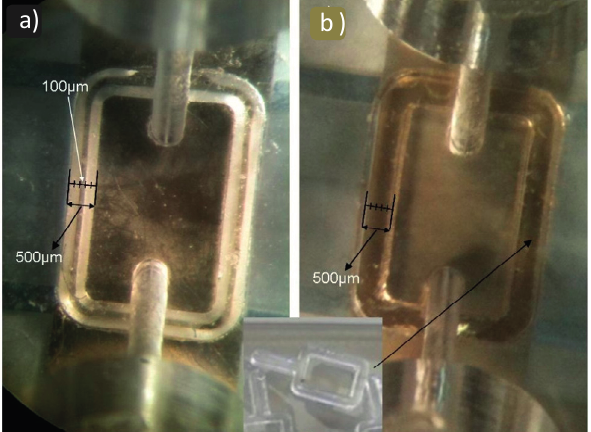
Figure 6. Real view of PDMS rectangular seals seen inside the cell through the transparent PMMA using an optical microscope. ( a ) Rectangular seal with peak-end; ( b ) Rectangular seal with